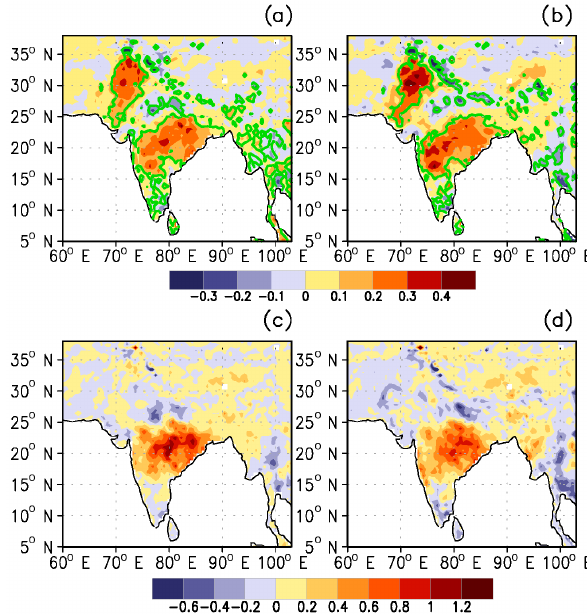
Figure 11. Difference (PLCS–HLCS) in seasonal (JJAS)-averaged 2m air temperatures (in ◦ C; 1982–2008) for (a) daily mean, and (b) daily maximum temperature. Green contour shows differences significant at the 90% confidence level. Difference (PLCS–HLCS) in the 90th percentile of daily 2m air temperature in JJAS (in ◦ C; 1982–2008), for (c) daily mean, and (d) daily maximum tempera-